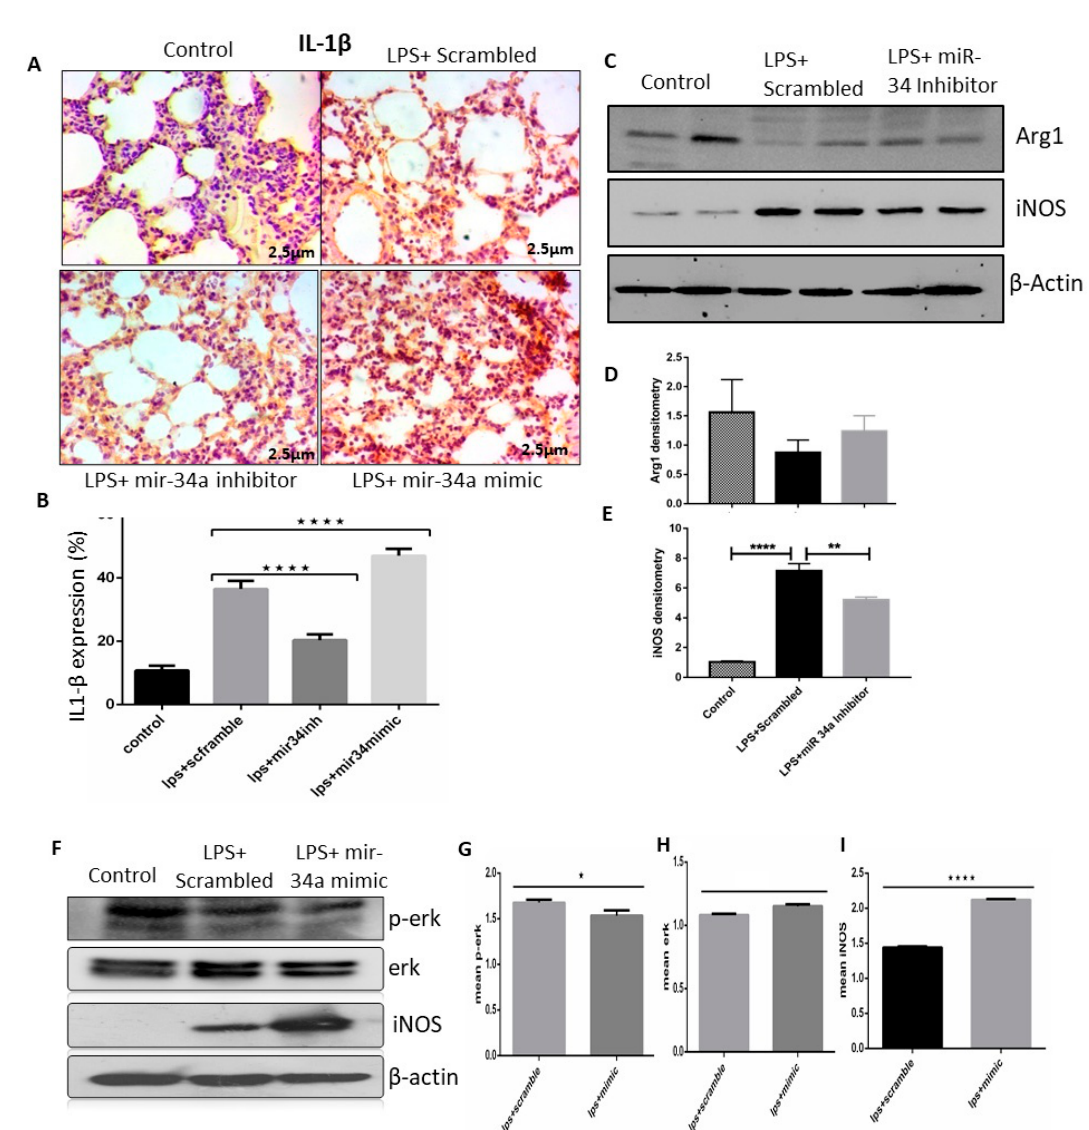
Figure 6. LPS e ff ectively induced miR-34a, which promoted the M1 phenotype of macrophages. Figure 6. LPS effectively induced miR-34a, which promoted the M1 phenotype of macrophages. ( A ) ( A ) Lung IHC staining of control, LPS + scrambled, and miR-34a + LPS treated mice groups showed expression of IL1- β . ( B ) Color density of IL1- β was quantified and analyzed using image J and two-way ANOVA following Tukey’s post hoc analyses. ( C – E ) Immunoblots of Arg1 and iNOS were performed in lung tissue lysates of mentioned groups. Densitometry was performed for all immunoblots and analyzed by two-way ANOVA following Tukey’s post hoc analyses. ( F – I ) RAW macrophages transfected with miR-34a inhibitor or scrambled; after treatment with LPS, cell lysates were performed to check the expression of ERK, p-ERK, and iNOS in given groups. Densitometry was done, and t-tests were used for analysis. * p < 0.05, ** p < 0.01, **** p < 0.0001 ( n =